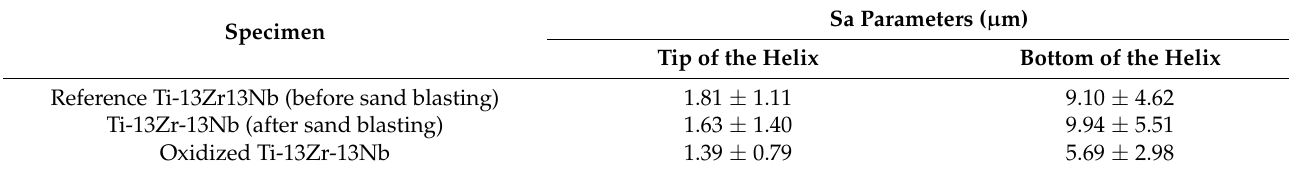
Figure 3. The topography of reference Ti-13Zr-13Nb before ( a ) and after ( b ) sand blasting and oxidized Ti-13Zr-13Nb surfaces ( c ) obtained by light microscopy; the bottom of the helix ( left ) and top ( right ). Table 3. Sa roughness parameters